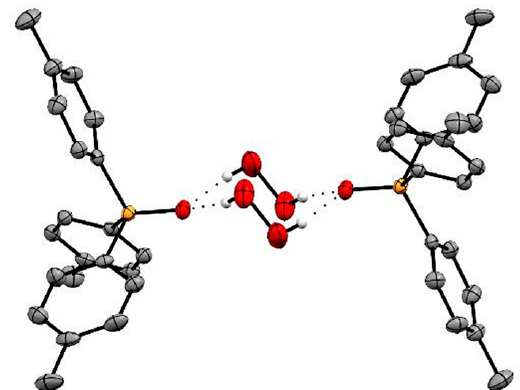
Figure 12. Bifurcate H-bonds, which are realized in isoleucine (TANDET, left panel) and β -alanine (TANDAP, right panel) peroxosolvates.